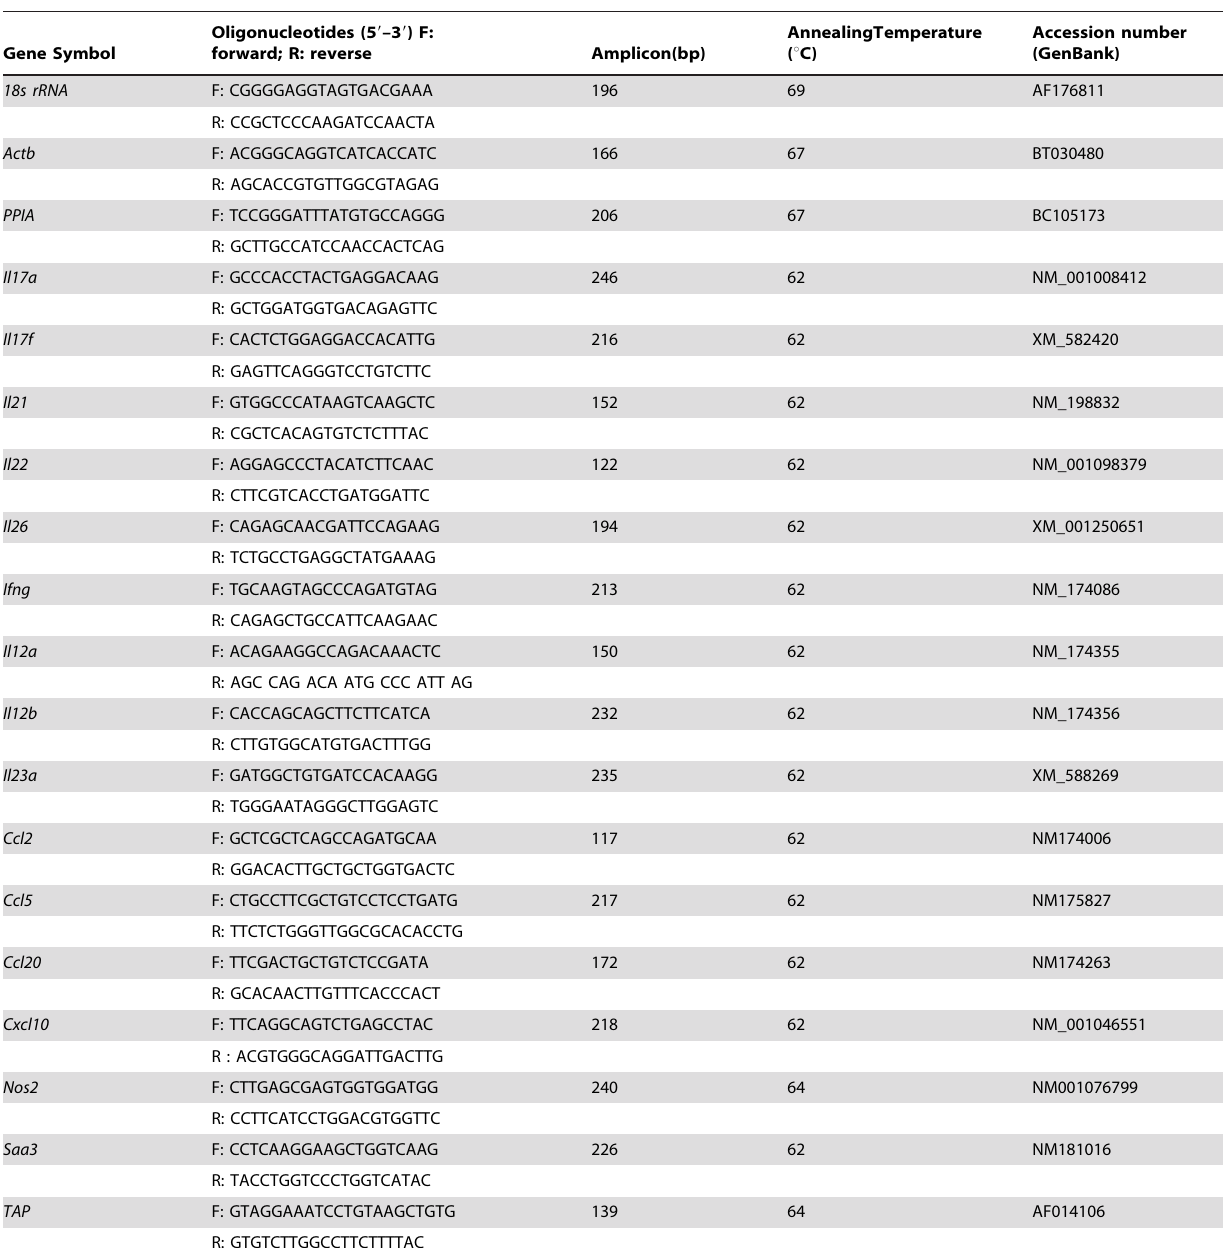
Table 1. Gene-specific oligonucleotide primers used for qPCR.